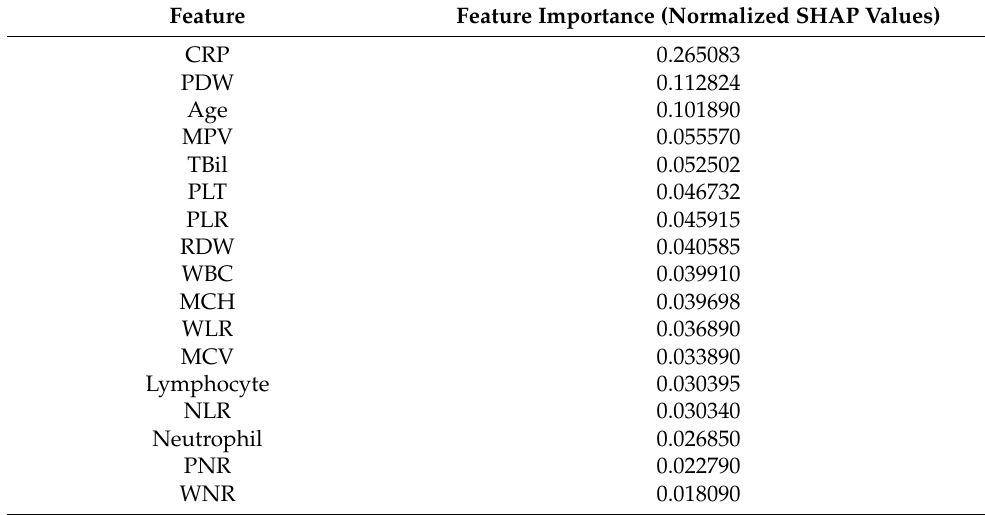
Table 4. Importance values of factors for classification of perforated